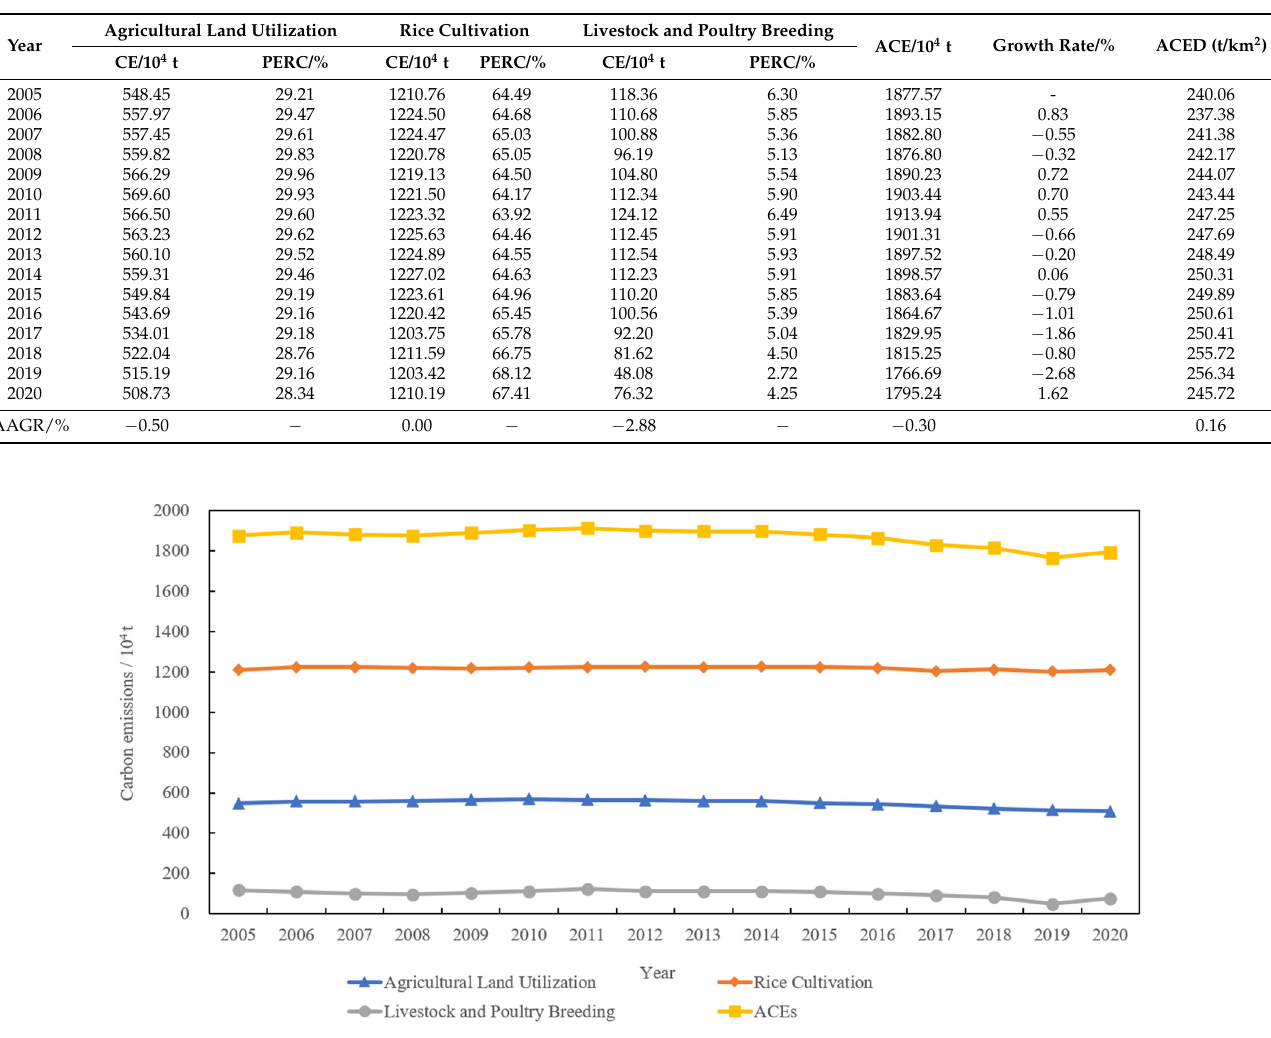
Table 3. ACEs in Jiangsu Province, China from 2005 to 2020.